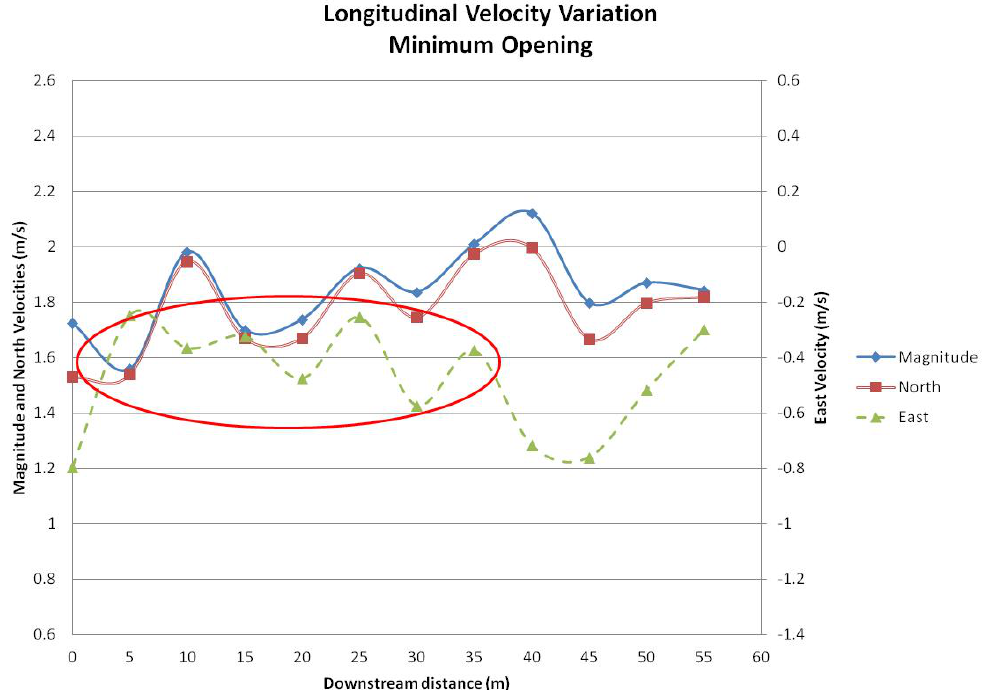
Figure 7. The main flow characteristics along the longitudinal profile. Minimum DDD opening. The red oval shows a limited velocity variation in the east direction.